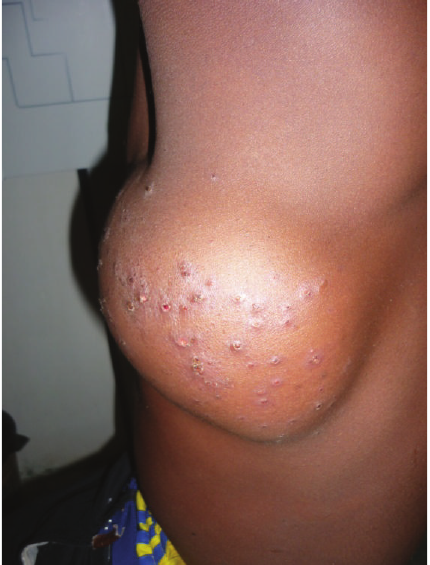
Figure 1: Showing large solitary well defined swelling with pustules on the skin on left chest wall over 5th to 8th ribs area.